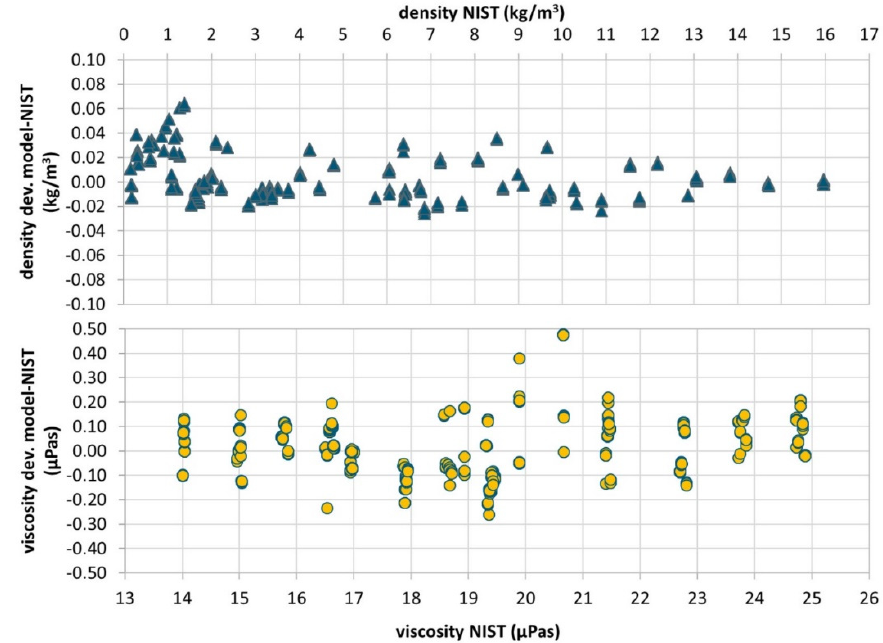
Figure 10. Density and viscosity measuring data of cantilever #149 calibrated according to the model described in Appendix A.1. Measurements for 4 gases (N 2 , CO 2 , Ar and He) at temperatures between 4.5 and 60 °C and pressures from 1 to 10 bar are shown. Deviations of the model estimations from the theoretical values from NIST Refprop Database [19] are plotted. Viscosity data not includes the measurements with helium at pressures lower than 6 bar, where the proposed model for viscosity does not work.